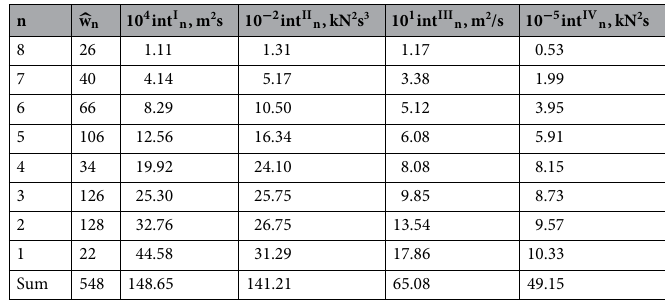
Table 2. Identity weighting sub-matrices (default choice): Q 1 = I , Q 2 = I , Q 3 = I , Q 4 = I